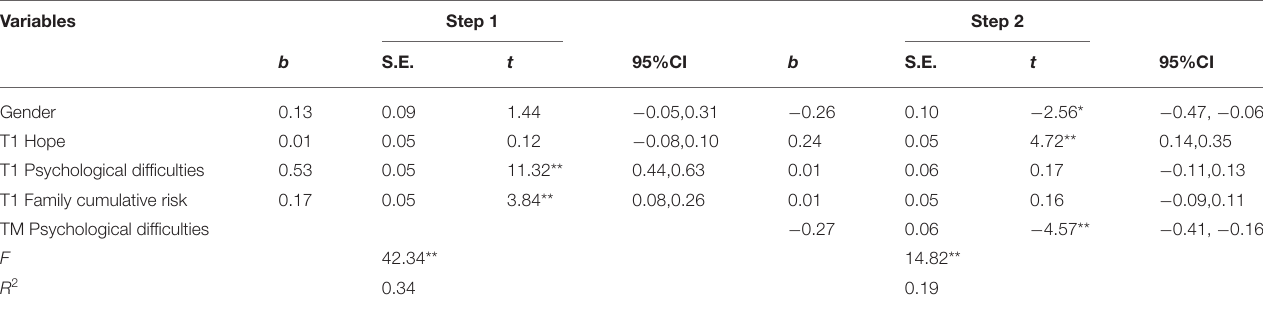
TABLE 3 | Regression results of testing the mediating model.